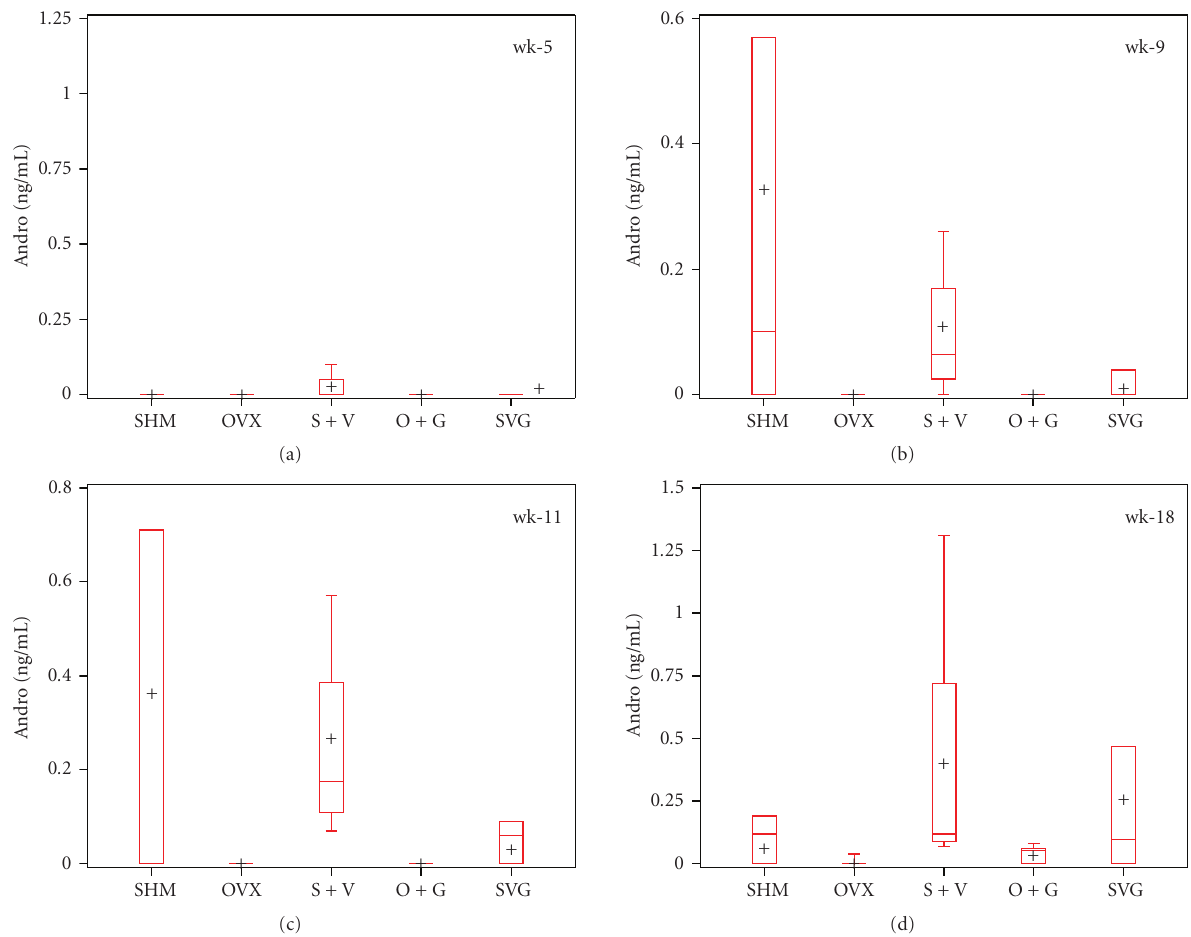
Figure 7: Treatment e ff ects on plasma androgen (ANDRO) concentrations of mice. The panel of boxplots illustrates the group medians (line within the box), means (+), interquartile range (length of the box), and the minimum and maximum values (extended whiskers) at each time point assessed. Data represent n = 3–6 samples/group. The Kruskal-Wallis test revealed the following P -values: wk-5, P = . 3732; wk-9, P = . 0387; wk-11, P = . 0142; wk-18, P = . 0593.